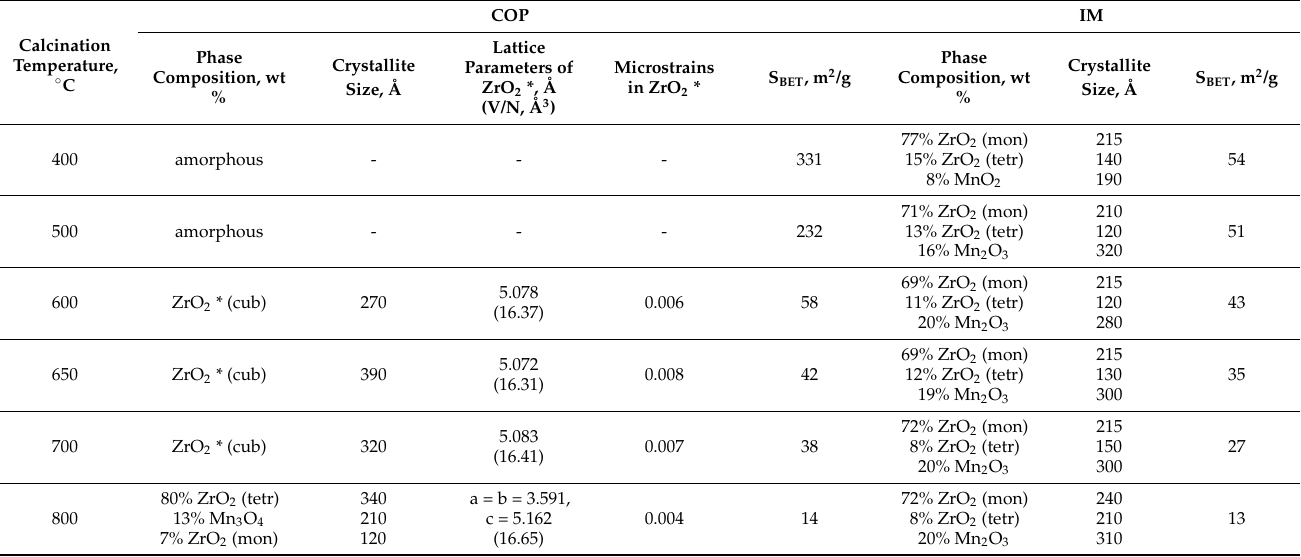
Figure 2. XRD patterns of IM ( a ) and COP ( b ) catalysts. Blue asterisks indicate the reflections of MnO 2 , black asterisks—Mn 2 O 3 , arrows—tetragonal ZrO 2 . The black bar chart indicates the position of monoclinic ZrO 2 reflections, black bars—cubic ZrO 2 . Table 2. Relative atomic concentrations of Mn and Zr cations in the near-surface layer of the studied Table 1. Structural and microstructural characteristics of the IM and COP catalysts.